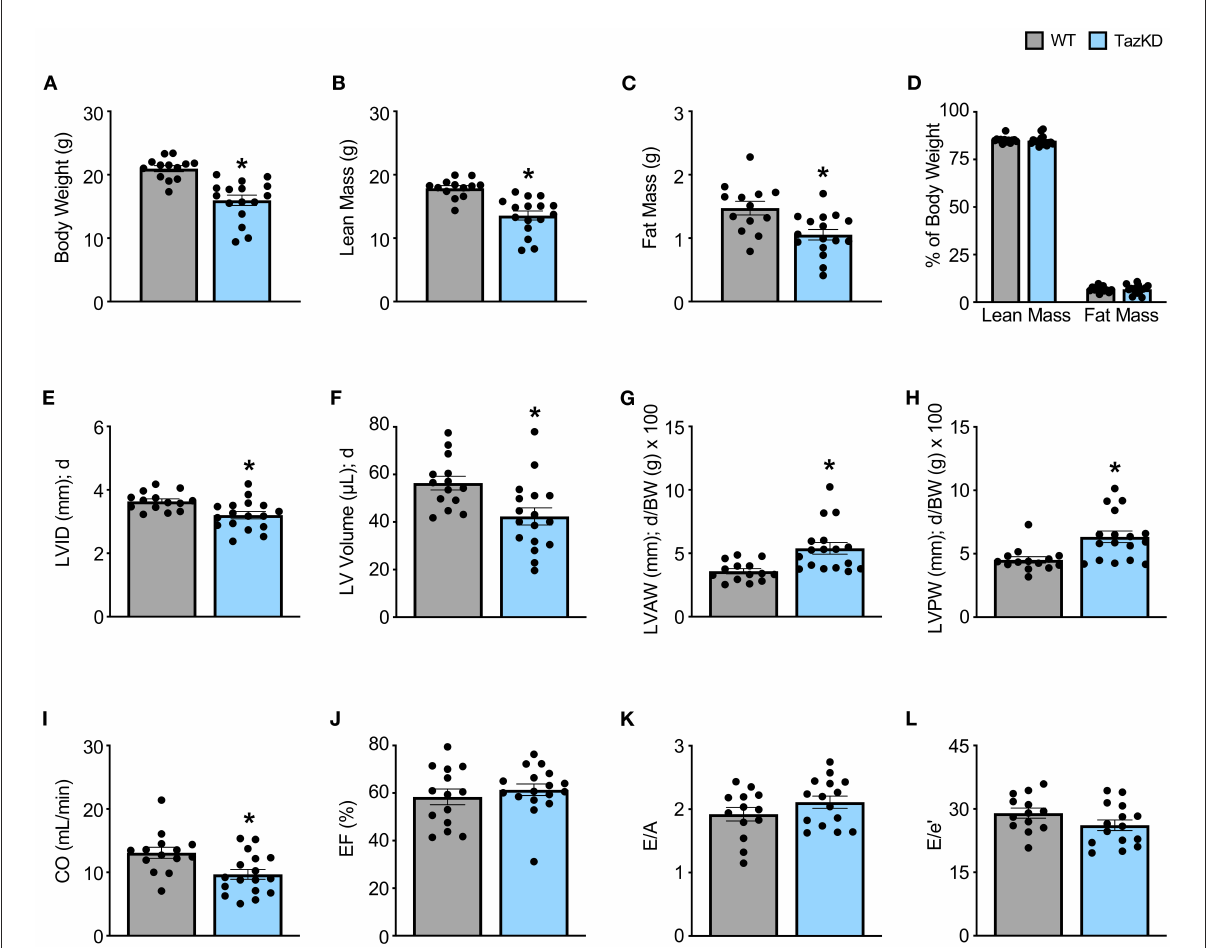
FIGURE1 Cardiac hypertrophy is already present in TazKD mice at 5 weeks of age. (A–D) Body weight and body composition (lean mass, fat mass) analysis in 5-week-old TazKD mice and their WT littermates (WT: n = 13, TazKD: n = 16). Ultrasound echocardiography was used to assess left ventricular (LV) chamber and wall dimensions including (E) LV internal diameter (LVID), (F) LV volume, (G) LV anterior wall thickness (LVAW), (H) and LV posterior wall thickness (LVPW) during diastole (d), in addition to functional parameters including (I) cardiac output (CO), (J) ejection fraction (EF), (K) E/A, and (L) E/e’ in 5-week old TazKD mice and their WT littermates. For structural and systolic function parameters (WT: n = 14, TazKD: n = 17); for diastolic function parameters (WT: n = 13, TazKD: n = 15). Values represent mean ± SEM. Differences were determined using an unpaired, two-tailed Student’s t test. * P < 0.05 significantly different from WT littermates. BW, body weight.